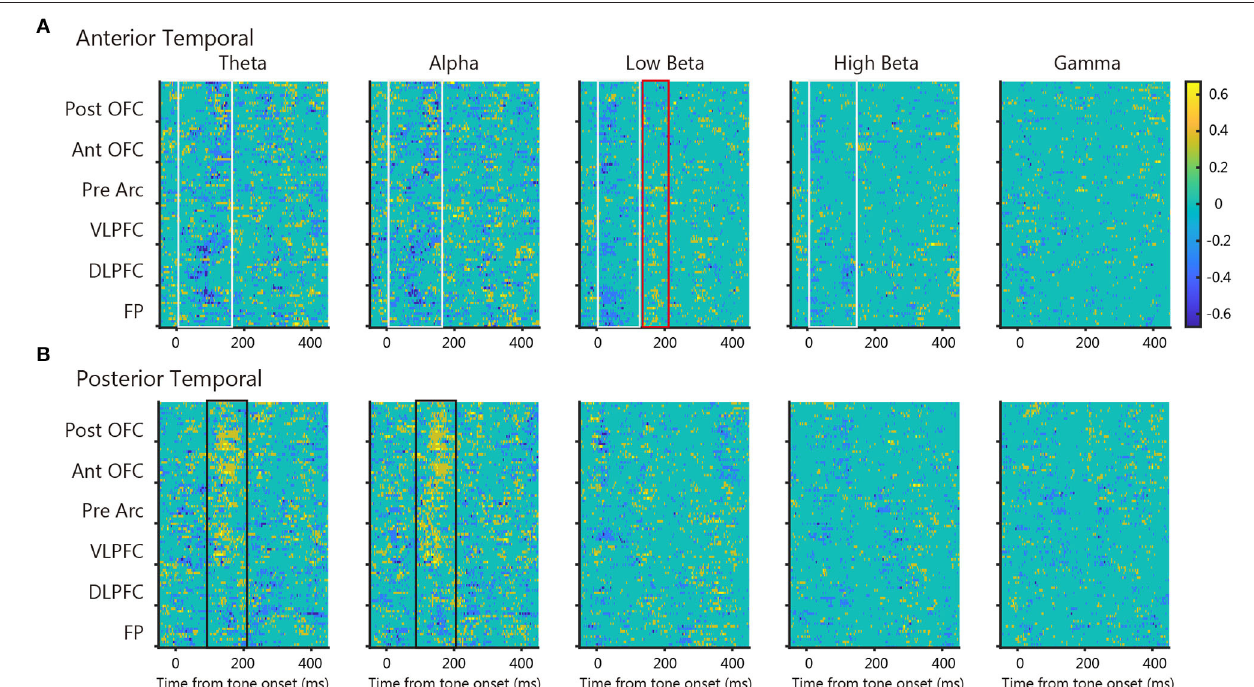
FIGURE 5 | The statistical difference map between tone presentation and tone omission PLV. Each map shows the time course of significant difference ratio of the three monkeys between tone presentation and tone omission PLVs for all prefrontal electrodes at each frequency band (cmtest, p < 0.05, uncorrected). Blue indicates that the tone presentation PLV was significantly larger than the tone omission PLV, and yellow vice versa . Colored boxes indicate important patterns in each map. (A) Maps of the anterior temporal seed. (B) Maps of the posterior temporal seed.